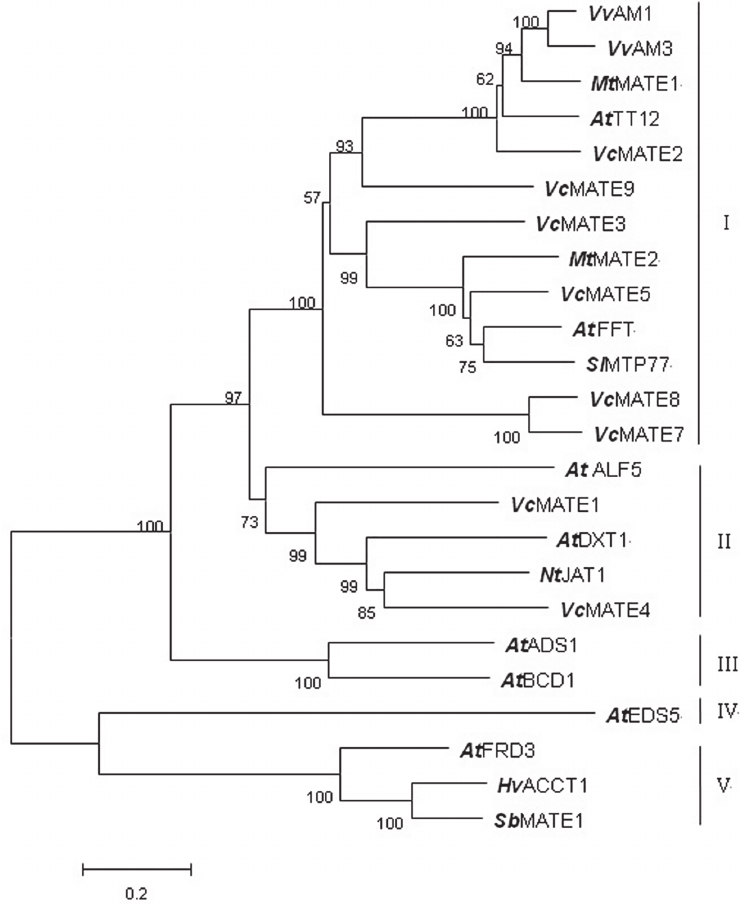
Fig 4. Phylogenetic tree of MATE transporters. Protein sequences of the characterized MATE transporters from Arabidopsis , TT12, FFT, ALF5, DXT1, ADS1, ZRIZI, EDS5, and FRD3; M. truncatula MATE1 and MATE2; sorghum Sb MATE1; grapevine AM1 and AM3; tomato MTP77; barley Hv AACT1; as well as tobacco JAT1 were aligned with Clustalx, and the nonrooted neighbor-joining tree was generated using the MEGA 5.0 program. Numbers at branch points indicate bootstrap support. The numbers above and below branches indicate bootstrap support percentages based on 1000